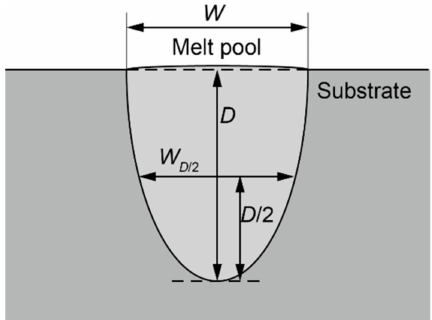
Figure 2. Definitions of W , D and W D